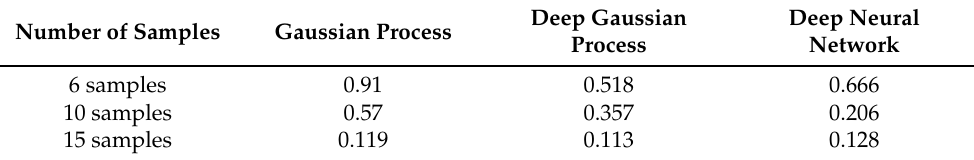
Table 11. CRMSE values with respect to the sampling density for each surrogate model.